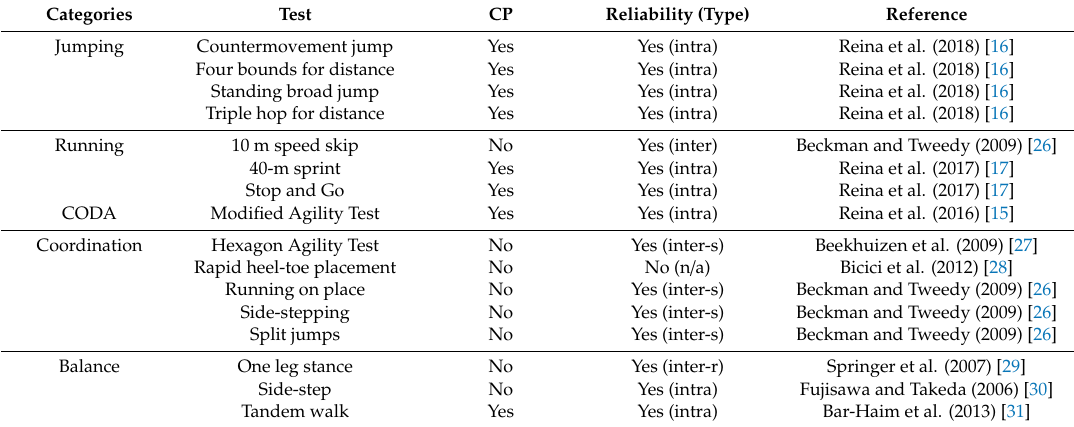
Table 3. Summary of tests divided into